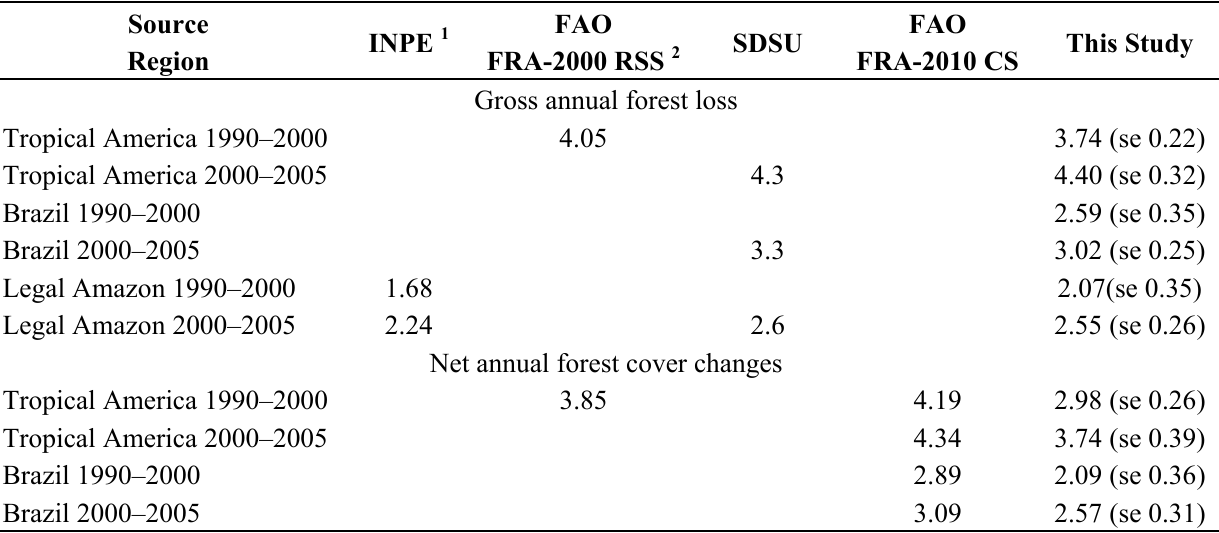
Table 4. Annual tropical forest cover change estimates for periods 1990–2000 and 2000–2005 for (i) South & Central America region; (ii) Brazil; (iii) Brazilian Amazon from different sources–from oldest to most recent publication date (in 10 6 ha/year)